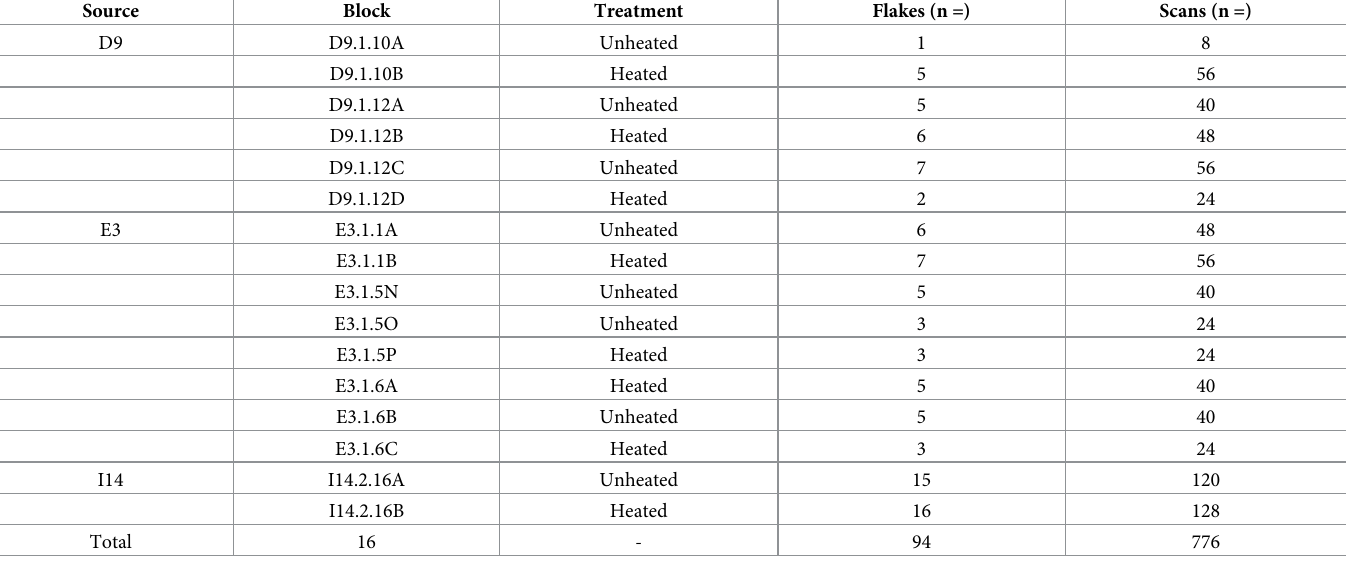
Table 1. Summary of the samples analyzed in this study and the number of flakes and scans per source. Source Block Treatment Flakes (n =) Scans (n